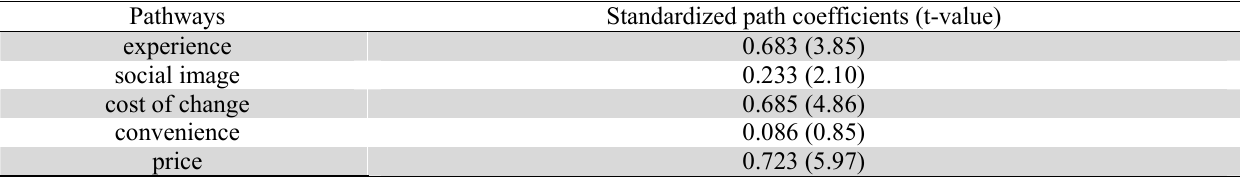
Result of latent formative